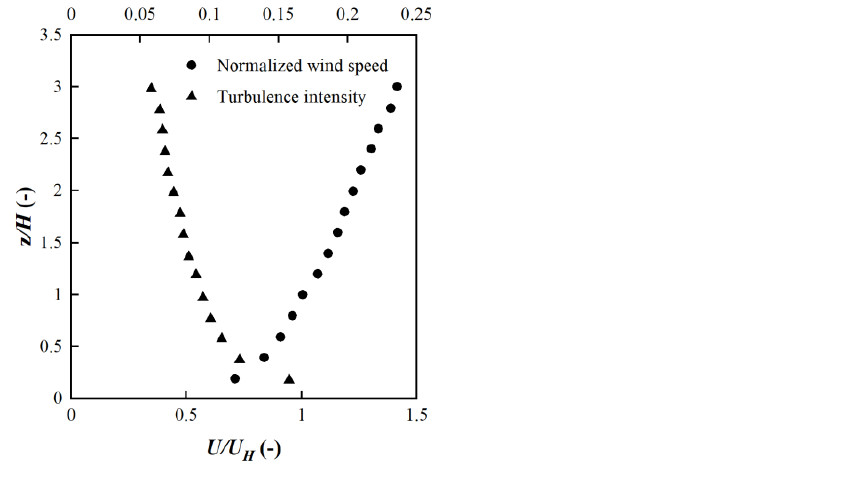
Figure 2. The profiles of normalized wind velocity U / U H and turbulence intensity I for the approach- ing flow of the experiment [20].